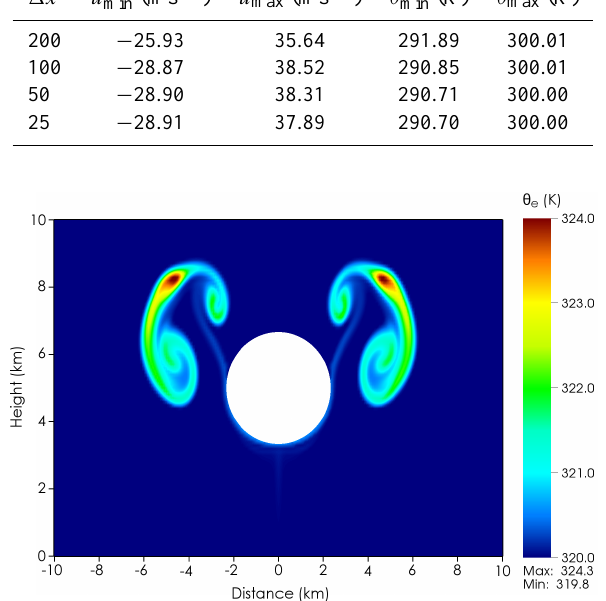
Figure 12. Equivalent potential temperature field for the moist rising bubble test including a zeppelin-shaped cut area in the center of the domain. Snapshot taken at t = 1250 s simulation time.